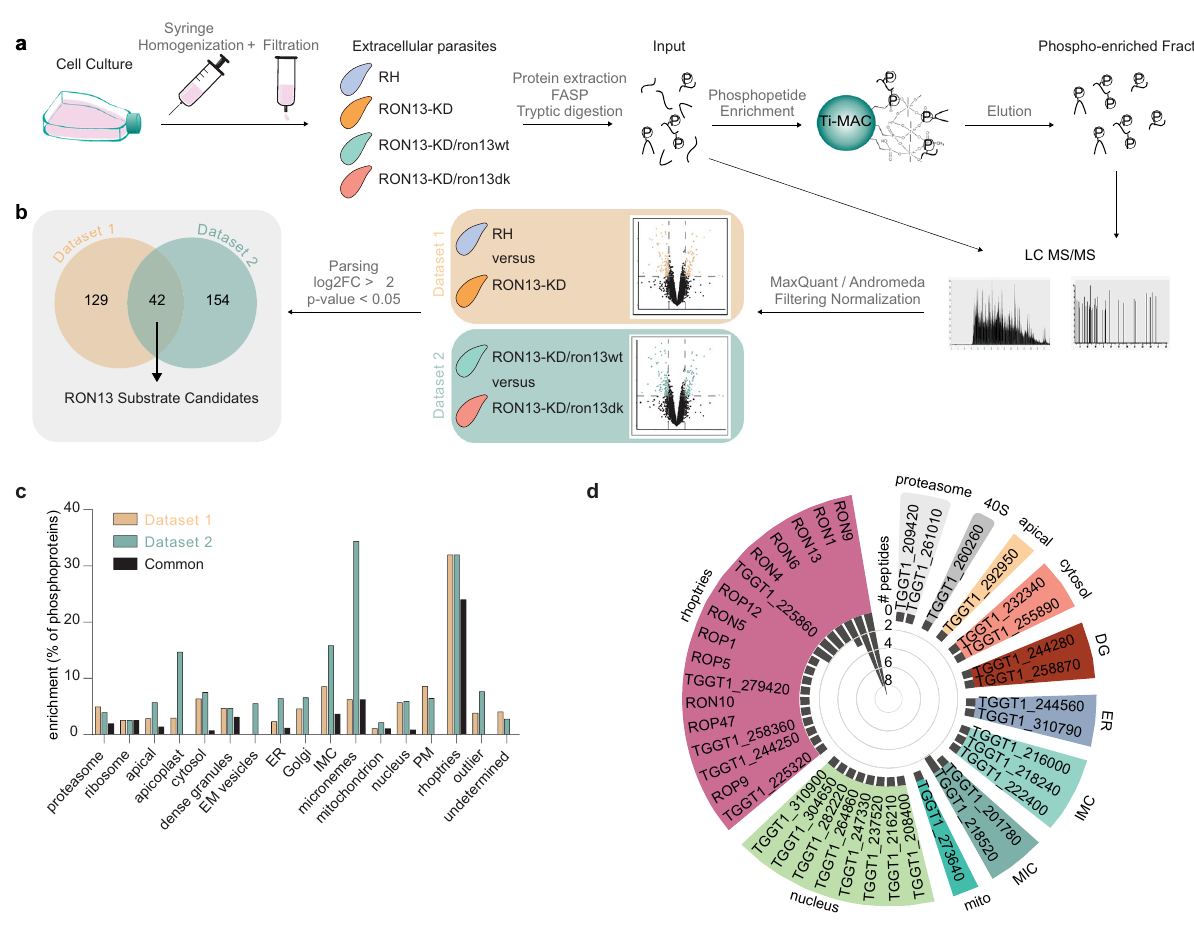
Fig. 6 Rhoptry proteins are the major substrate of RON13. a Work fl ow of the shotgun approach and phosphoproteome analysis used to identify RON13 substrates. Samples were prepared for each strain from four independent experiments ( n = 4 biologically independent experiments). RH (blue) RON13-KD (orange) RON13-KD/ron13wt (green) RON13-KD/ron13dk (salmon). b Venn diagrams of the phosphoproteins found in datasets 1 and 2. c Bar graph showing the percentage of phosphoproteins from datasets 1 and 2 relative to the total number of phosphoproteins, according to their predicted localization 23 . EM endomembrane, IMC inner membrane complex. d Polar plot of the number of phosphopeptides found in both datasets (common) binned by gene IDs and clustered, according to their predicted subcellular localizations 23 . Source data are provided as a Source data fi